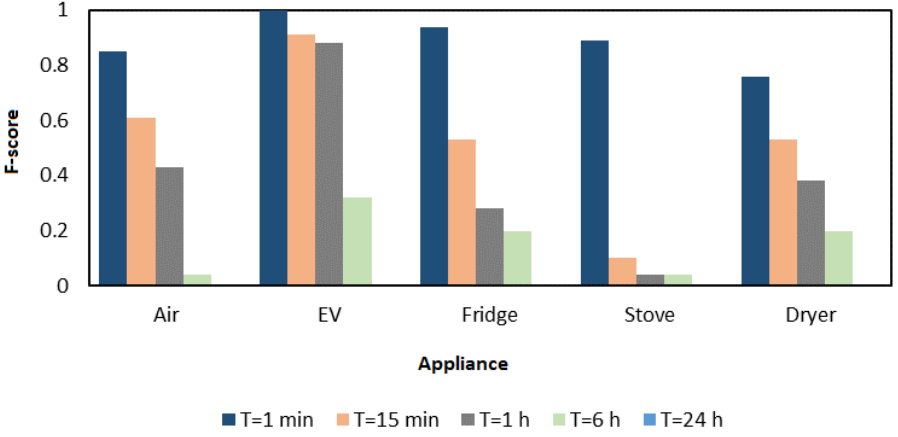
Figure 9. F-score of the NILMTK performance on appliances from different interval resolution.